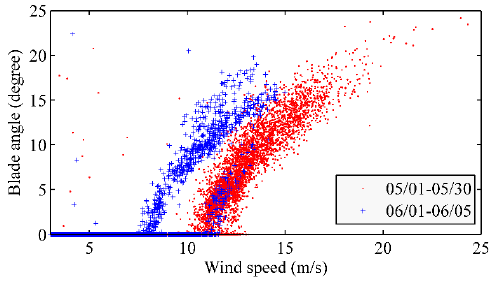
Figure 9. Relationship between pitch blade angle and wind speed during two time periods.